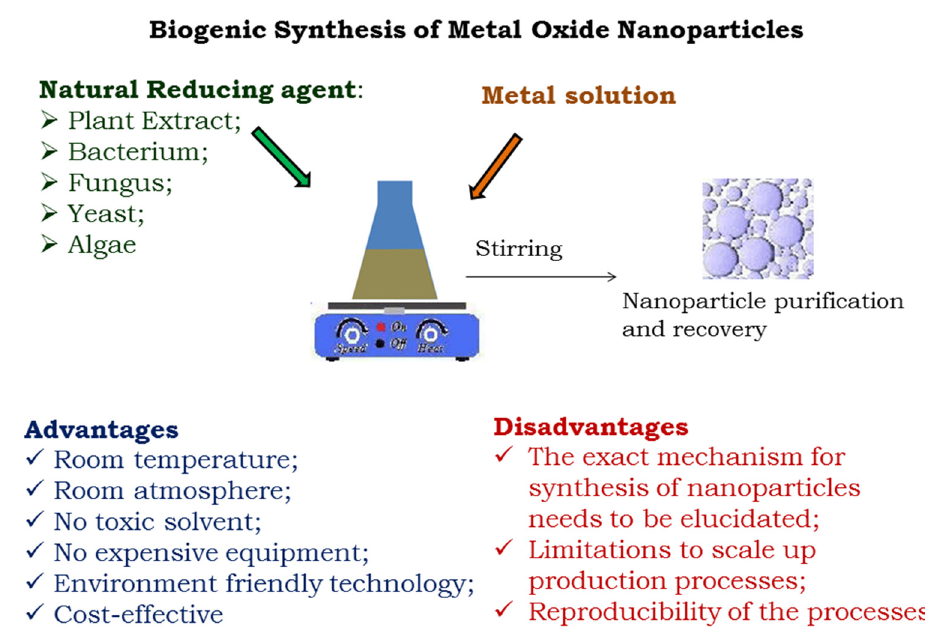
Figure 1. Schematic representation of the biogenic synthesis of metal oxide nanoparticles and its advantages and